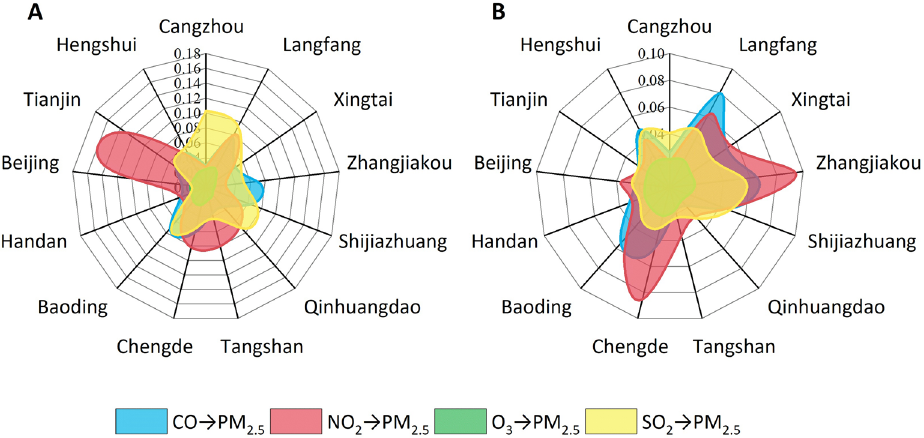
Figure 1. Quantitative NC impacts of ( A ) pollutants inside each city on PM 2.5 and ( B ) pollutants from peripheral cities on PM 2.5 in